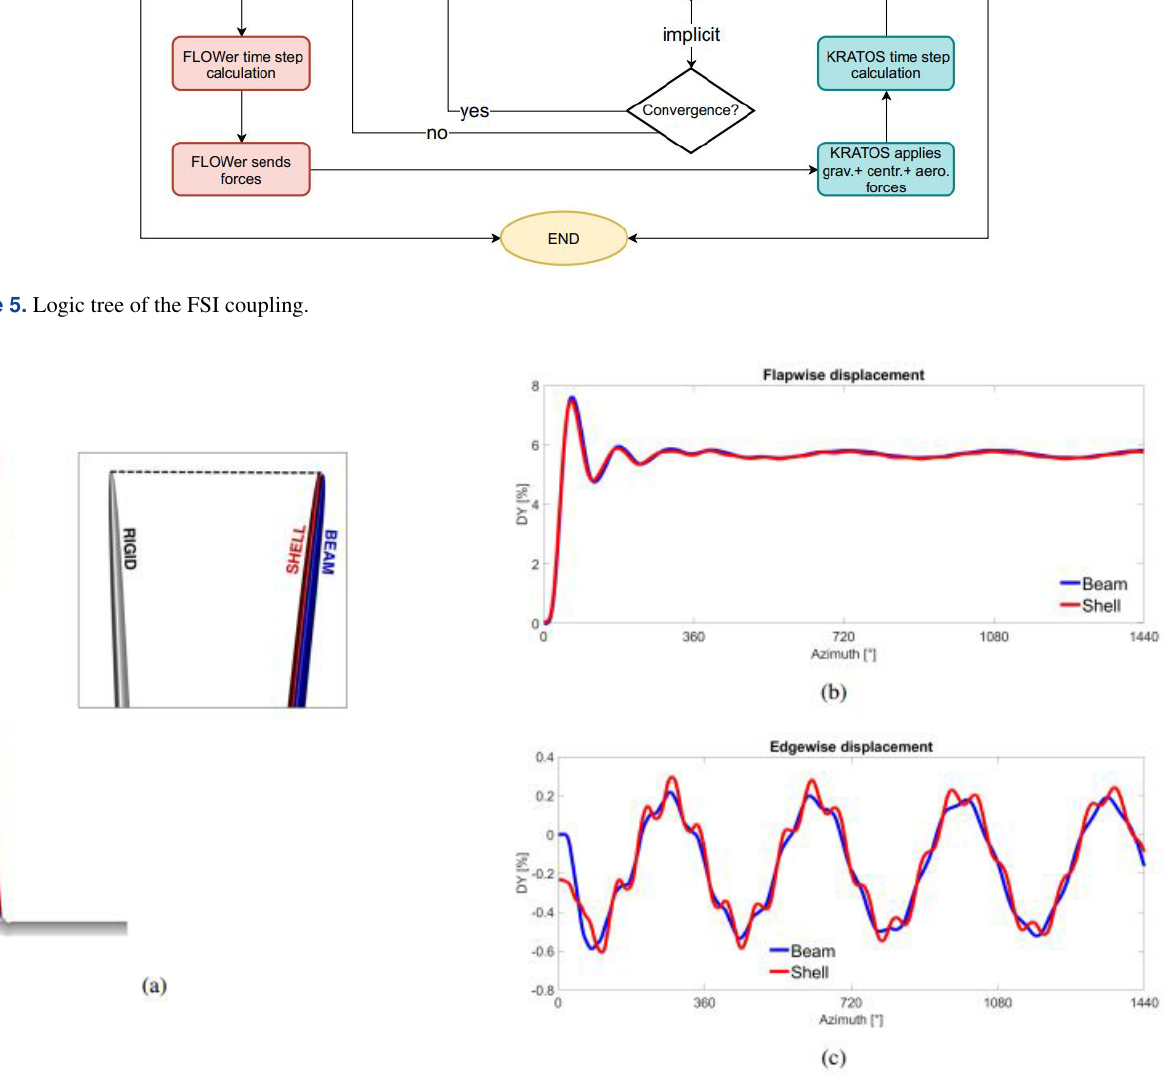
Figure 6. One-third model (OTM), rigid and deformed blade beam vs. shell. Deformations are normalized according to the blade radius and shown as a percentage of